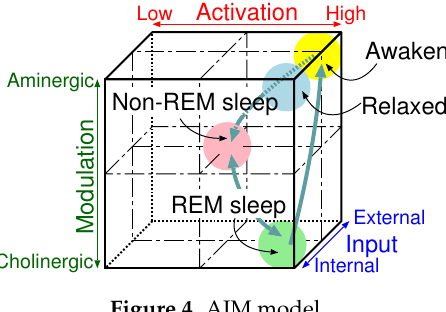
Figure 4. AIM model.